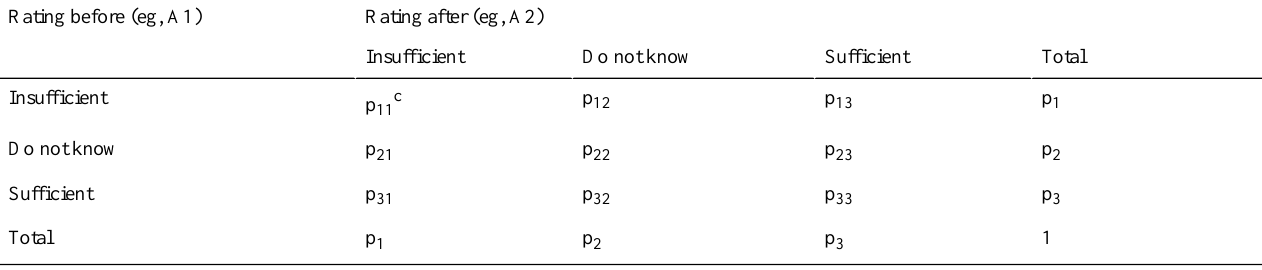
Table 1. Probabilities of the before-and-after paired decisions (eg, A1 a vs A2 b ).